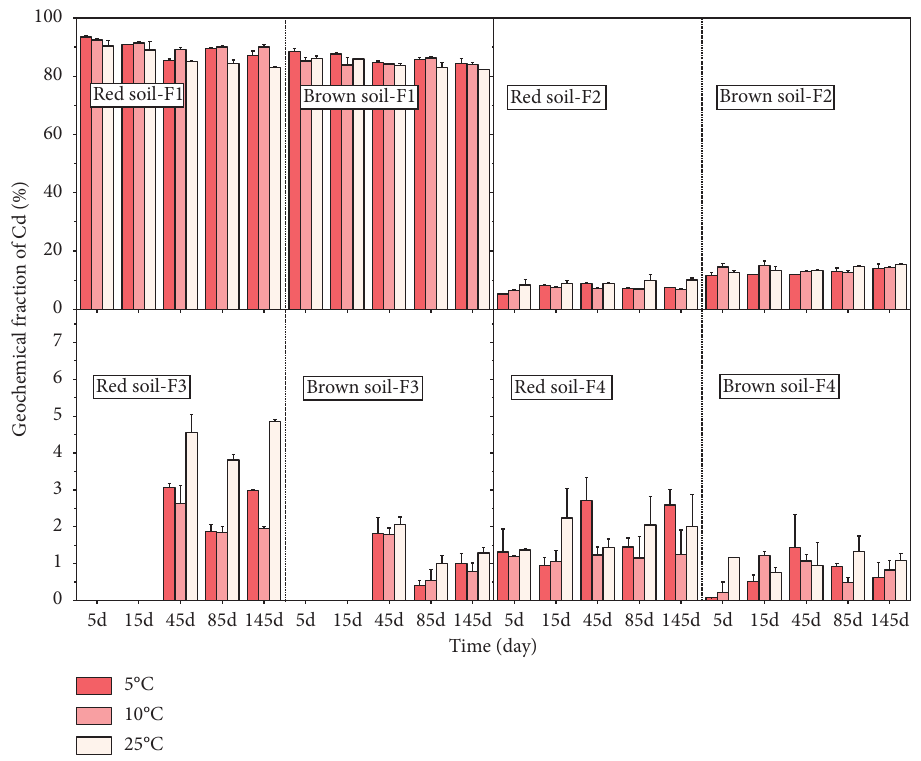
Figure 2: Changes in Cd fractions in soils at different temperatures as a function of contact Table 2: Pearson’s correlation of heavy metal speciation during aging experiments.